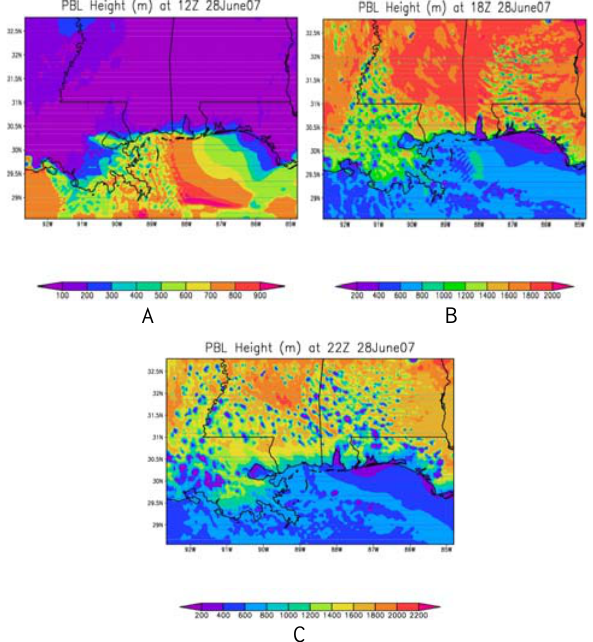
Figure 12: Simulated PBL height (m) at 0600 LT (A), 1200 LT (B) and 1600 LT (C) on June 28,